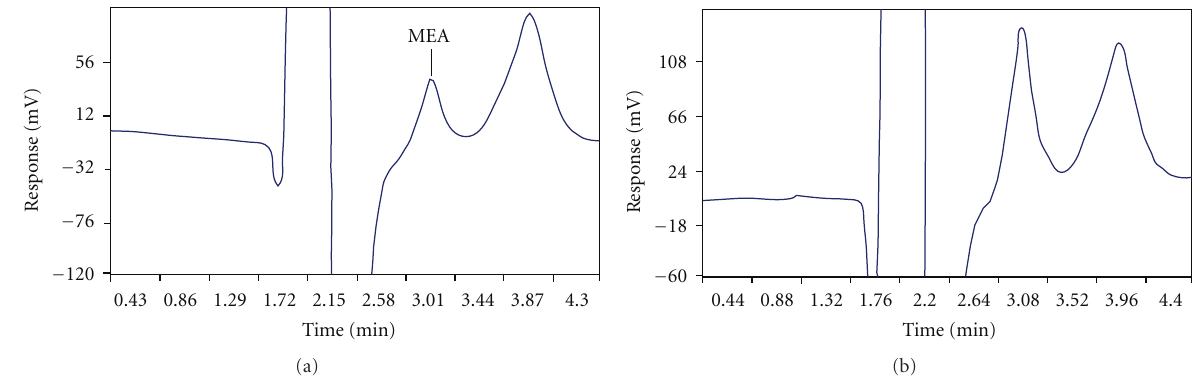
Figure 2: Chromatogram of steam generator water samples showing (a) MEA peak and an impurity peak (b) enhancement of the MEA peak on spiking the sample solution with MEA (5 µ gmL − 1